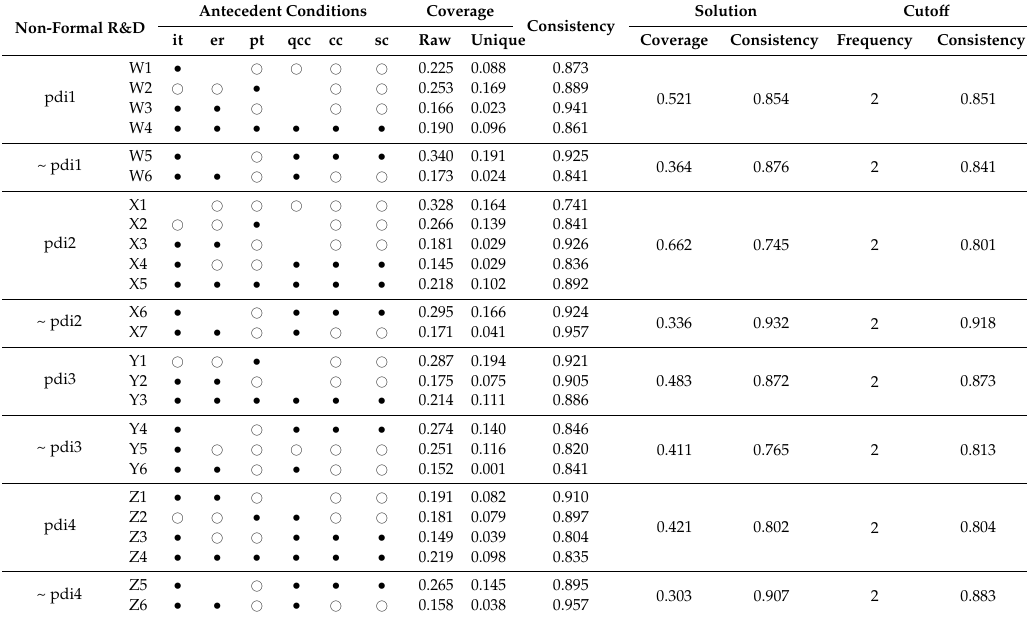
Table 8. Configurations of internal HRM practices and supply chain collaboration in non-formal R&D